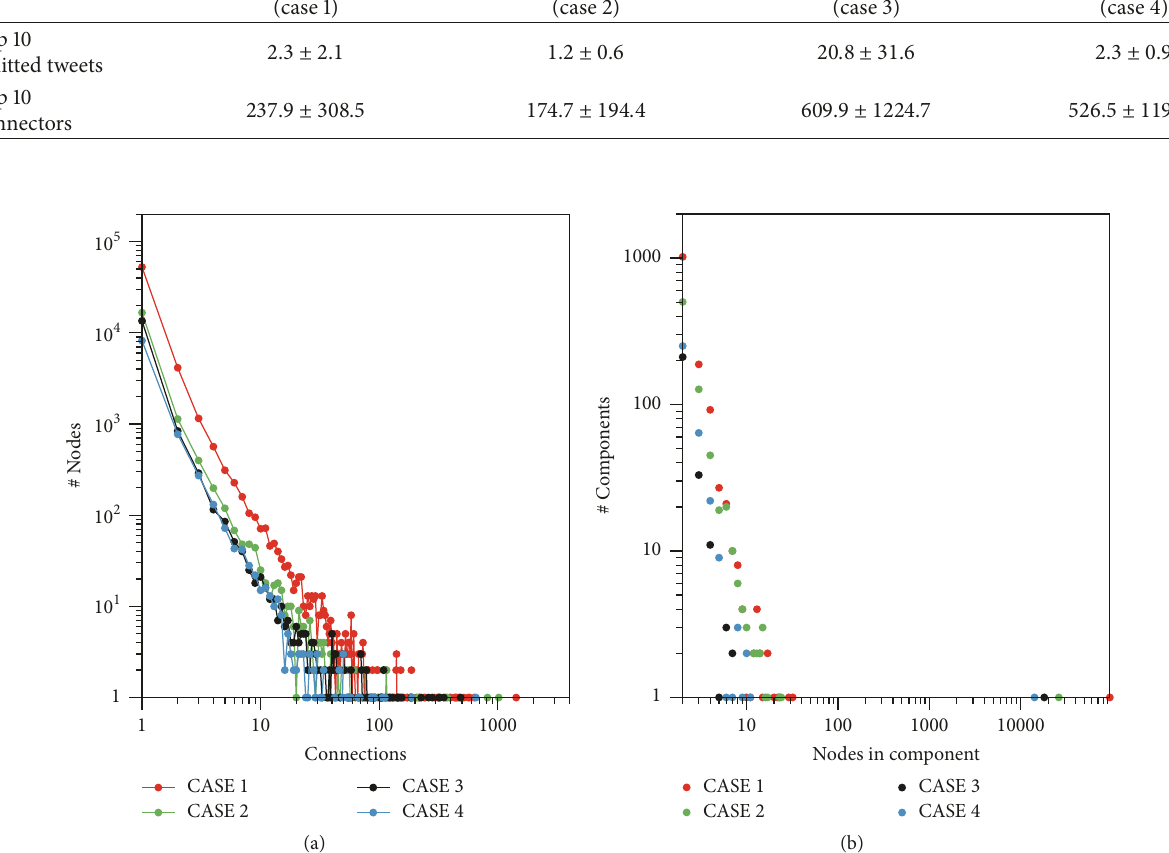
Figure 5: Distribution of nodes according to their connectivity (a) and distribution of component size (b) for 𝐺(𝑑) graphs corresponding to the period of greatest activity in each